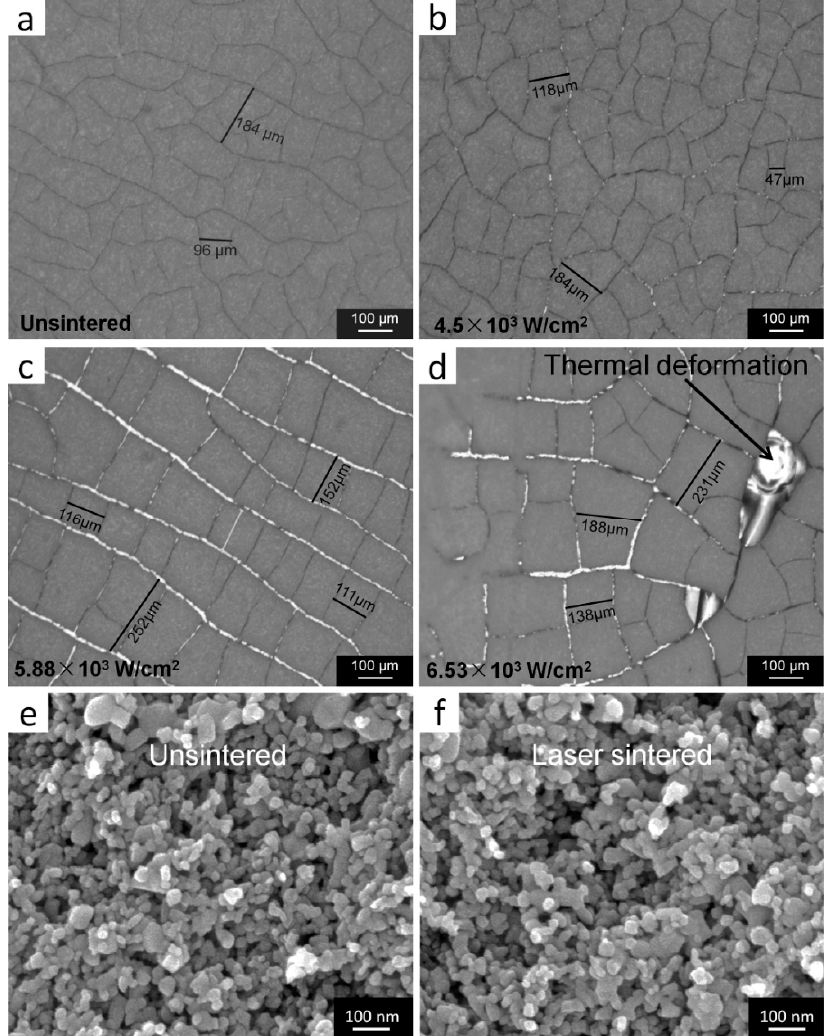
Figure 3. Microscope photographs of IR laser sintered TiO 2 films with the laser power density of ( a ) 0, ( b ) 4.5 × 10 3 W/cm 2 , ( c ) 5.88 × 10 3 W/cm 2 , ( d ) 6.53 × 10 3 W/cm 2 , SEM images of ( e ) original TiO 2 film, ( f ) IR laser sintered TiO 2 films with the laser power density of 5.88 × 10 3 W/cm 2 .